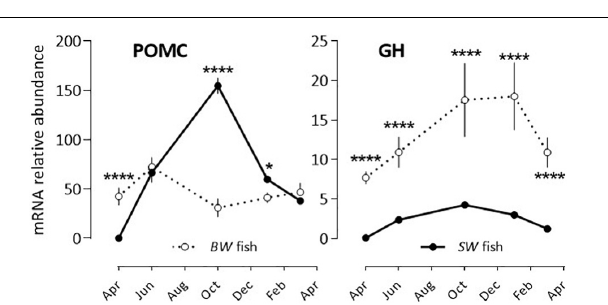
FIGURE 2 | Relative annual variations in POMC and GH mRNA abundance in sea bass pituitaries in vivo . Same conditions as indicate in the legend of Figure 1 . Mean ± S.E.M. ( n = 6). Two-way ANOVA ( Table 2 ) and Holm-Sidak’s post hoc test was used for comparison of means between the